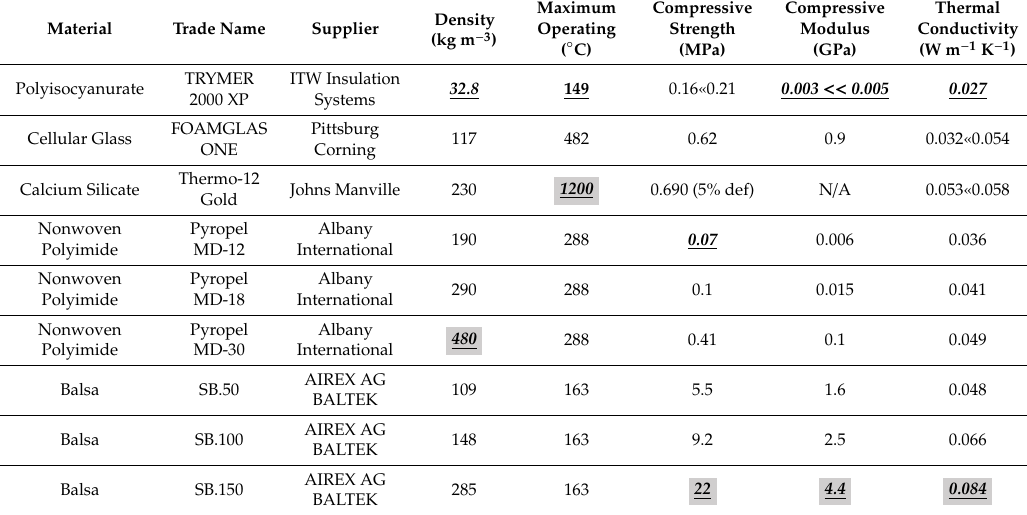
Table 2. Semi-ridged materials considered as insulation of the quasi-adiabatic PEMFC fixture. The highest and lowest material properties values of each type are underlined and the highest is further identified by a shaded gray box. Not available (N / A).